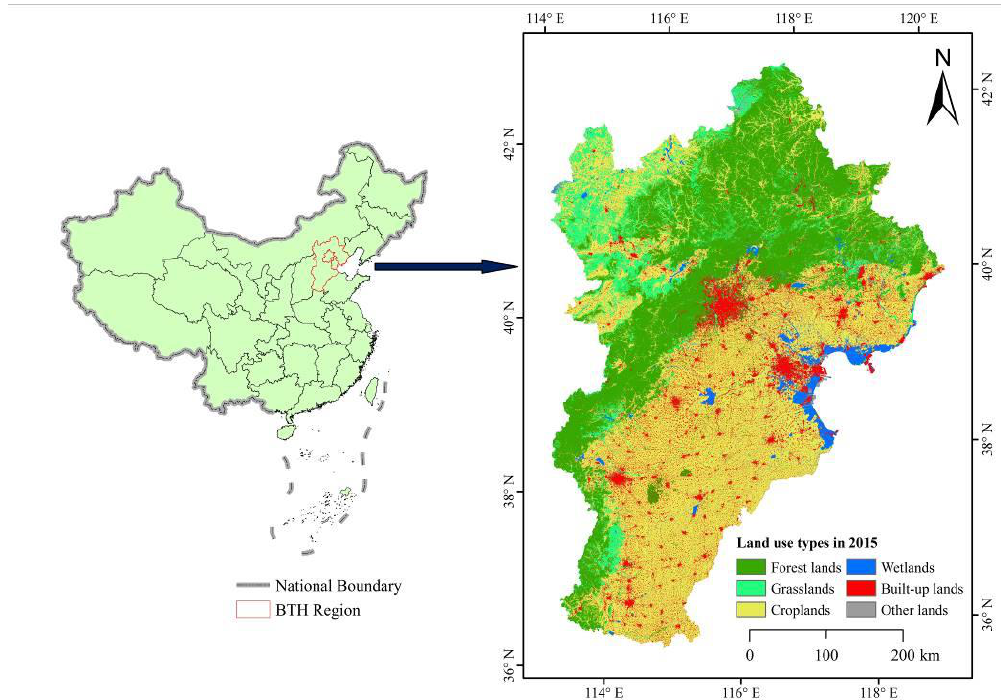
Figure 1. Location of the study site known as the Beijing-Tianjin-Hebei region (BTH).